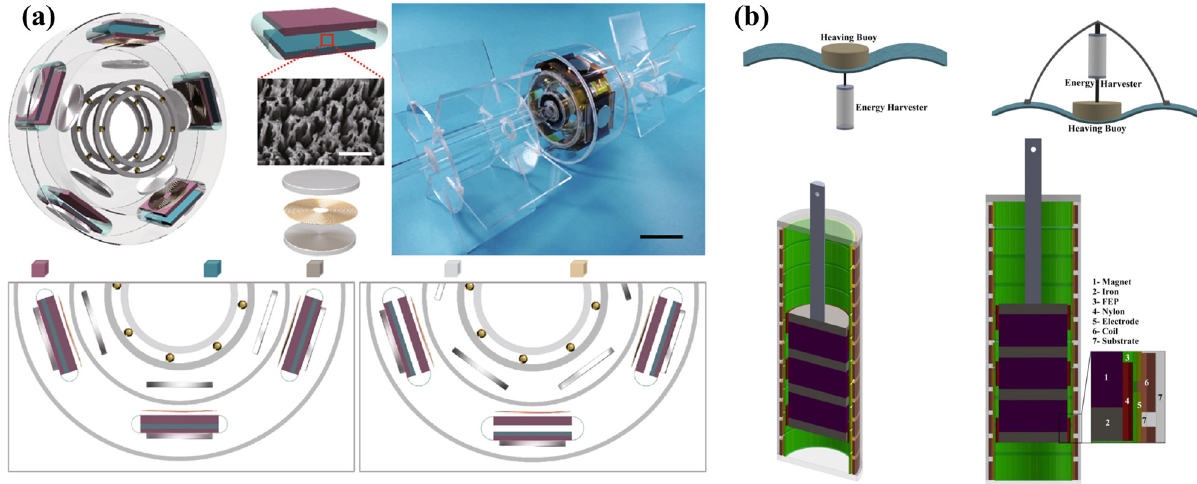
Figure 10: ( a ) Structure of the triboelectric – electromagnetic hybrid generator ( TEHG ) [ 80 ] and ( b ) structure of the hybridized triboelectric - electromagnetic generator based on heaving point absorbers [ 85 ]